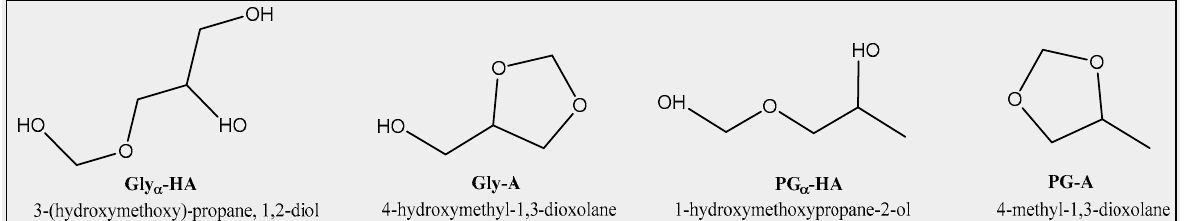
Figure 2. Formaldehyde-containing hemiacetal (Gly α -HA and PG α -HA) and acetal (Gly-A and PG-A) adducts.